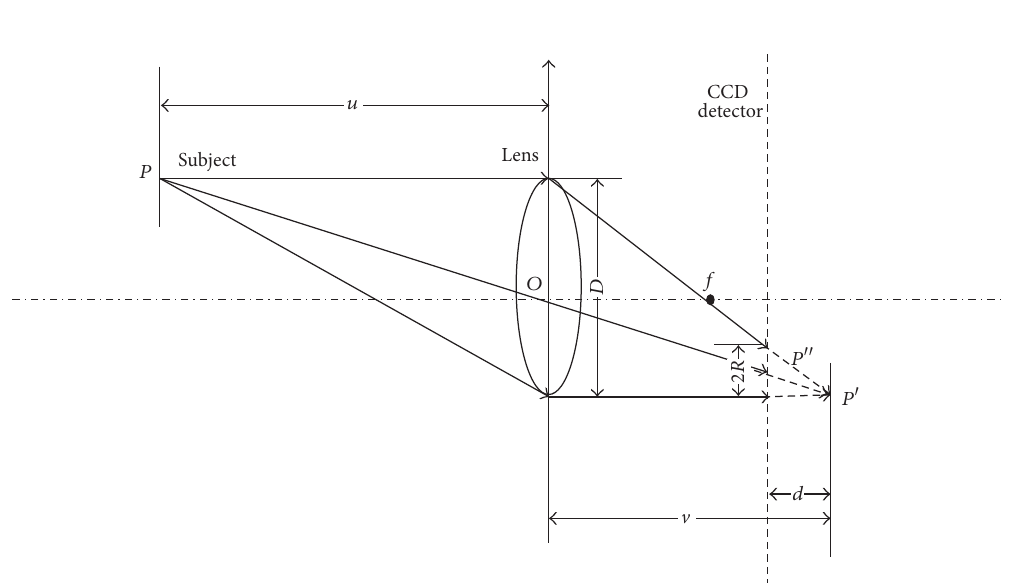
Figure 3: Optical imaging system model diagram with CCD detector before 𝑃 󸀠󸀠